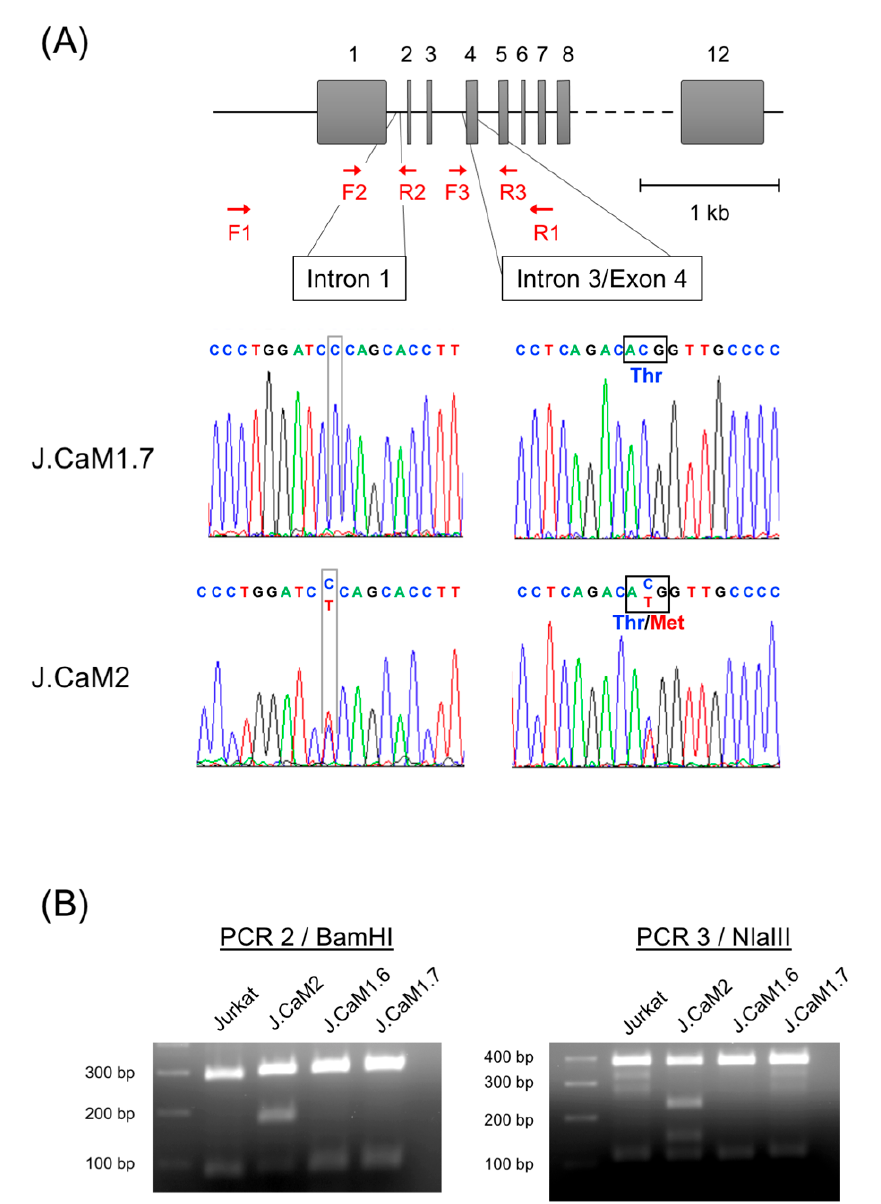
Figure 3. Sequence analysis in LAT gene of J.CaM1.7 cells ( A ) Schematic representation of the human genomic region of LAT gene and histograms showing homozygous wild type “C” nucleotides in intron 1 (position g.237) and exon 4 (position c.167) in J.CaM1.7 cells. As a control, the same sequence analysis was performed in J.CaM2 cells, and heterozygous variants C > T in positions g.237 and c167 are shown. F1 and R1: primers used to amplify genomic DNA to be sequenced. F2, F3, R2 and R3: primers used for sequencing. ( B ) Mutations in J.CaM2 cells were confirmed by the digestion of PCR product 2 (amplified with primers F2 and R2 from genomic DNA) with BamHI endonuclease (for the mutation in intron 1) and by the digestion of PCR product 3 (amplified with primers F3 and R3) with NlaIII. As it can be observed, only J.CaM2 cells presented both mutations, and cells J.CaM1.6 and J.CaM1.7 presented the same genotype as Jurkat